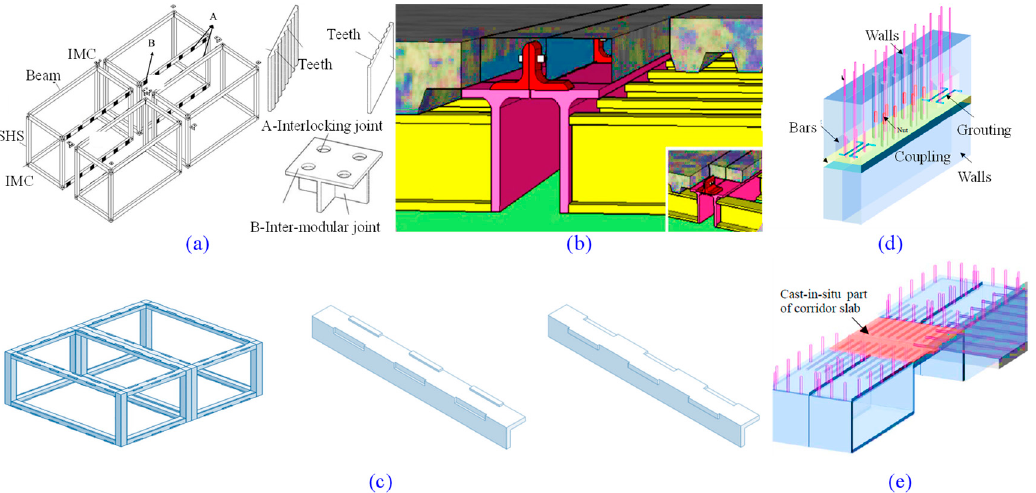
Figure 7. IMC for the continuous horizontal and vertical diaphragm. ( a ) beam-to-beam horizontal teeth lock [92]; ( b ) beam-to-beam vertical bolted clips [99]; ( c ) beam-to-beam horizontal and vertical sawed systems [79]; ( d ) wall-to-wall vertical cast-in situ rebars [97]; and ( e ) diaphragm-to-diaphragm horizontal cast-in situ rebars [98] IMC.